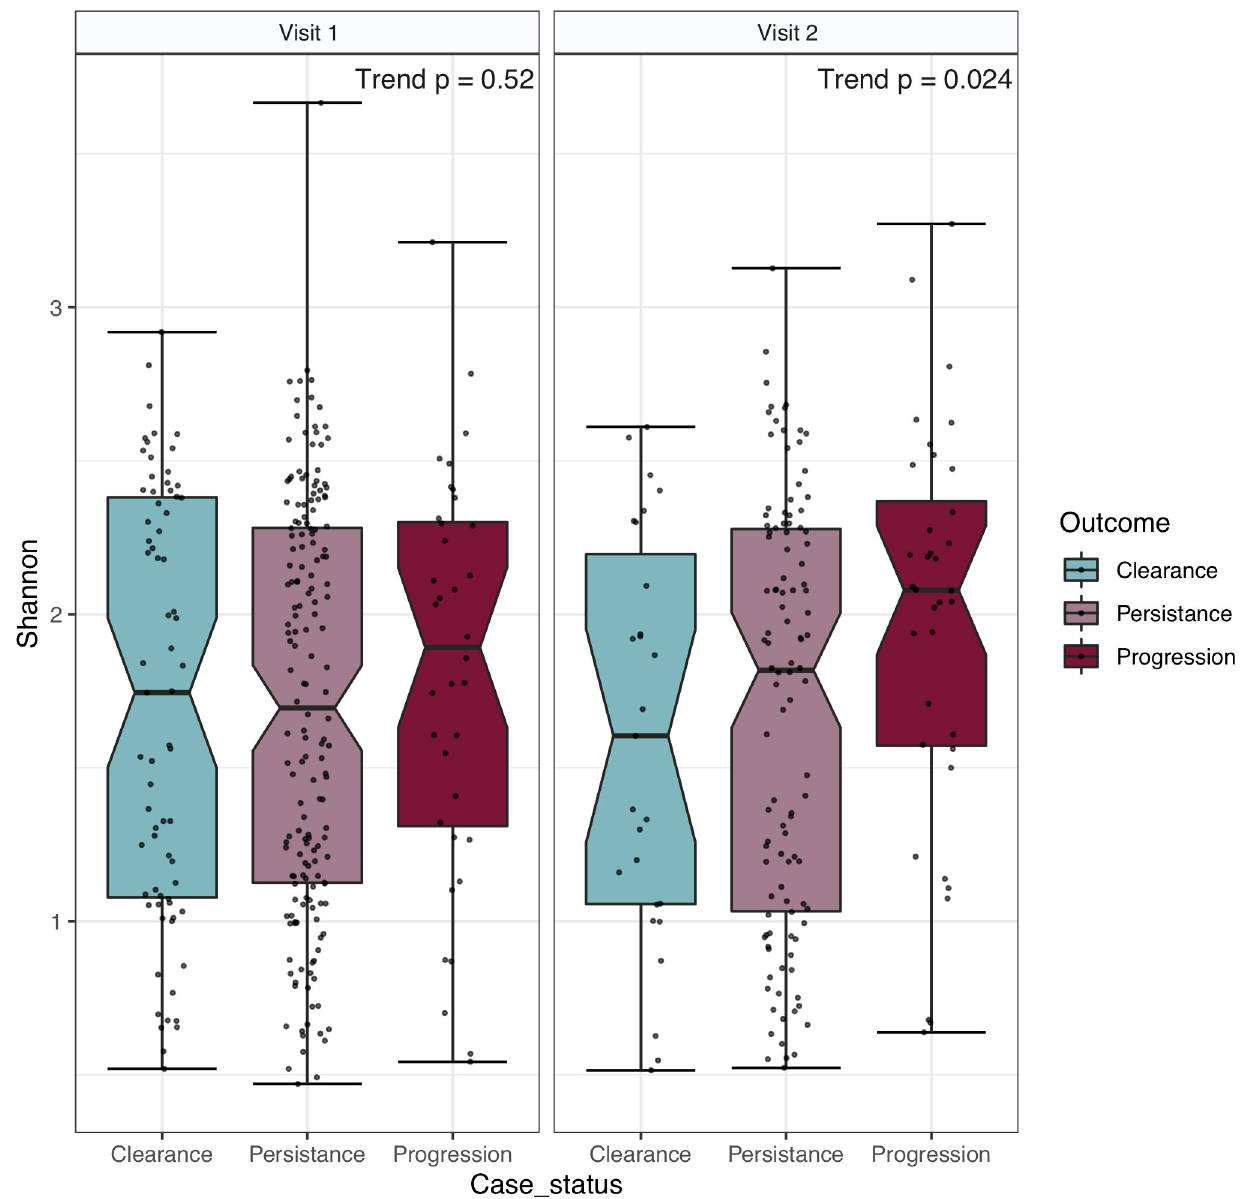
Fig 2. Bacterial Shannon diversity by visit. HR-HPV category specific microbial Shannon diversity is shown for V1 and V2. Horizontal strip labels at the top of the figure indicate visit number. V1 has an elevated diversity in the progression group, but the overall trend did not achieve statistical significance (p = 0.52). At V2 the observed trend of a rising Shannon alpha diversity from clearance to persistence to progression was statistically significant, p = 0.024.